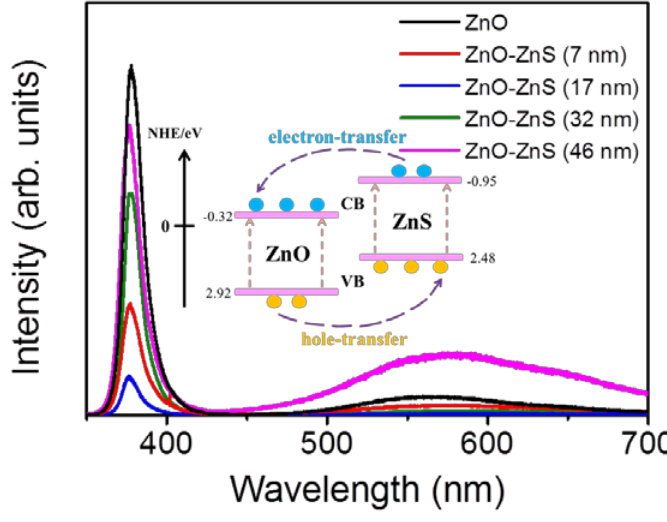
Figure 4. PL spectra of ZnO-ZnS composite nanorods with various sputtering ZnS thicknesses.